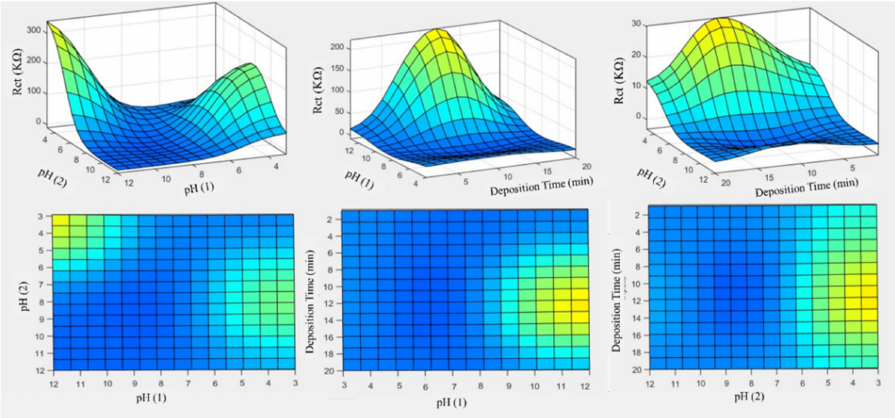
Figure 13. The 3D and 2D plots were obtained from the ANFIS model for Rct of